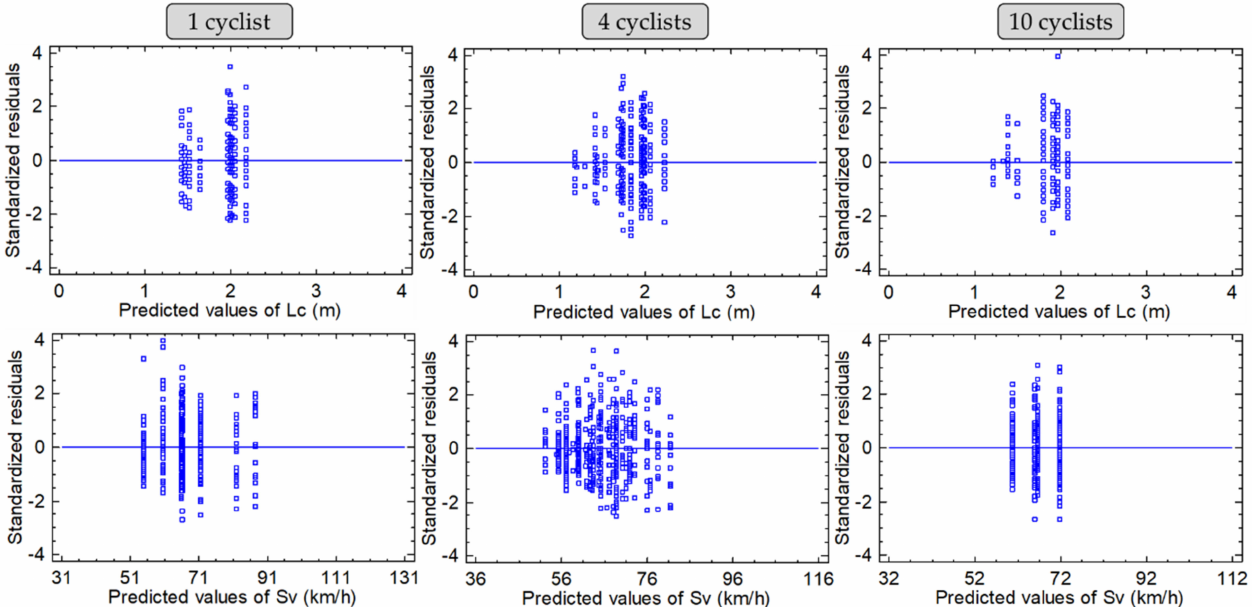
Figure 5. Standardized residual plots for lateral clearance ( upper ) and overtaking speed ( bottom